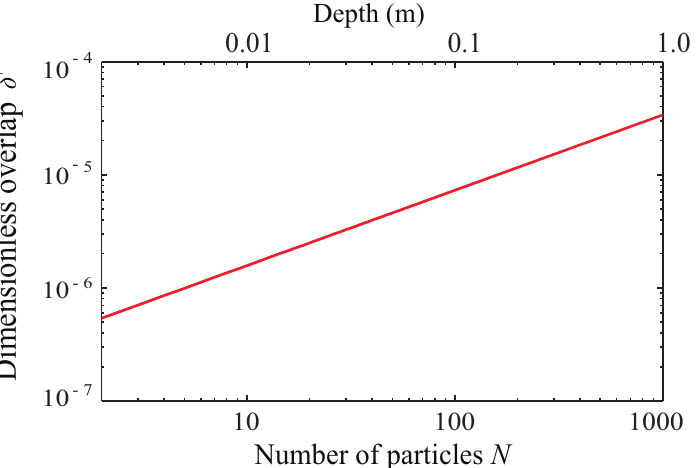
Figure 4. The changes in overlap with depth for densely packed glass particles with radii of 0.5 cm. It can be seen that the logarithm of depth, number of particles or external force is proportional to the deformation δ n